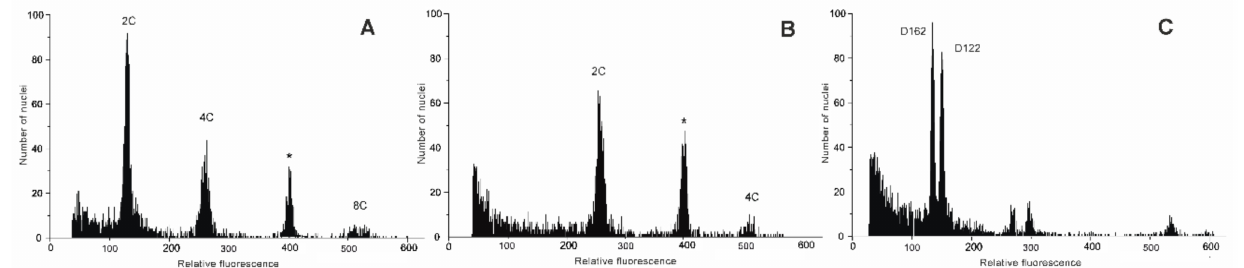
Figure 3. Histograms of fluorescence intensities of diploid ( A ) (population D19) and tetraploid ( B ) (population D17) accessions of D. sylvestris , together with the internal reference standard Bellis perennis (asterisk), from which relative genome size (RGS) was calculated. The peaks are labelled following Greilhuber et al. [1]. Multiple peaks of the sample correspond to nuclei after one (4C) and two (8C) rounds of endoreplication. ( C ) Histogram showing genuine difference between diploid populations D162 (0.325 ± 0.001) and D122 (0.360 ± 0.004).